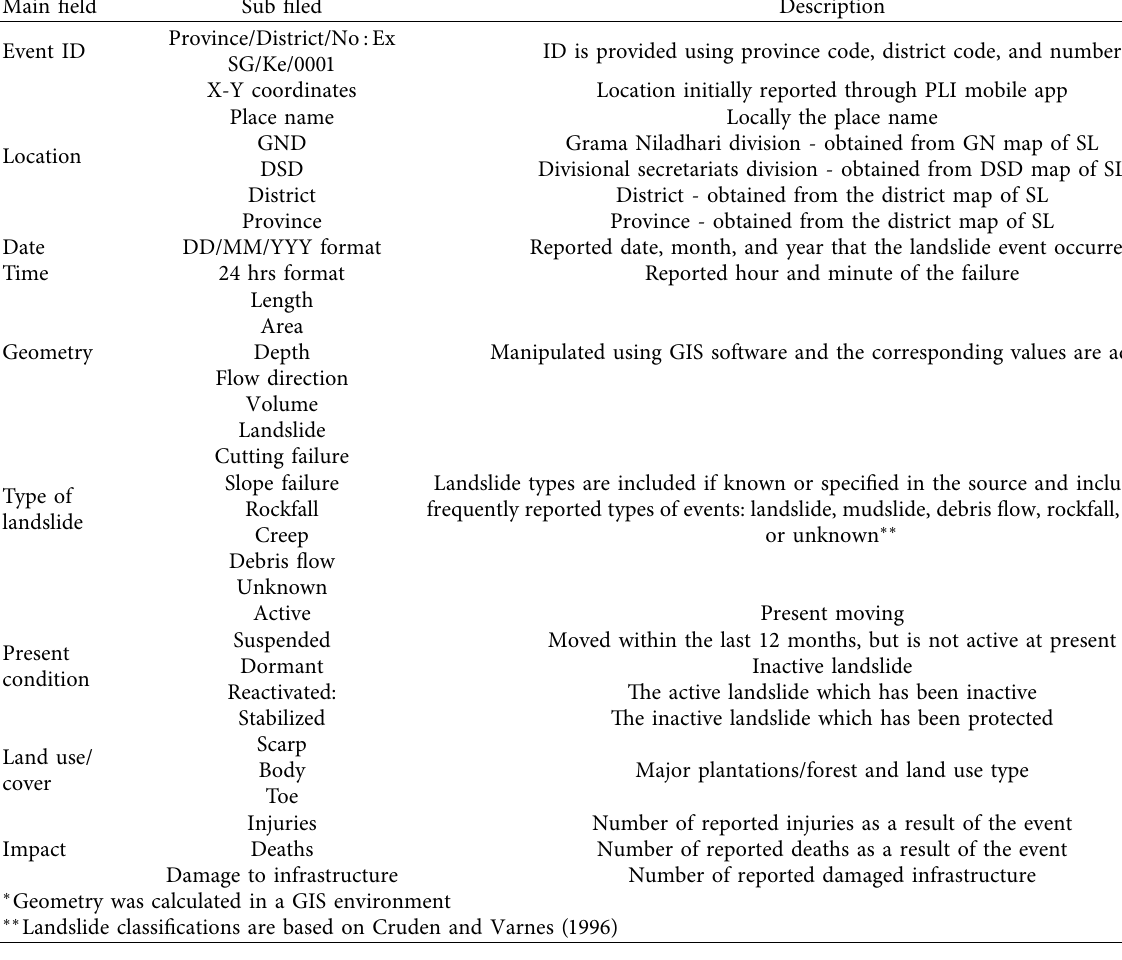
Table 1: Summary of fields included in the participatory landslide